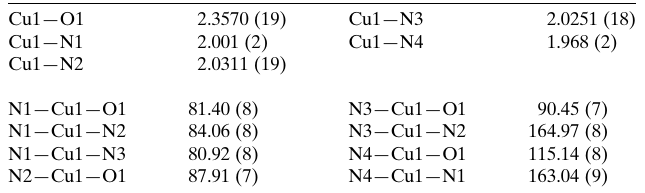
Table 1 Selected geometric parameters (A˚ , (cid:4) ).